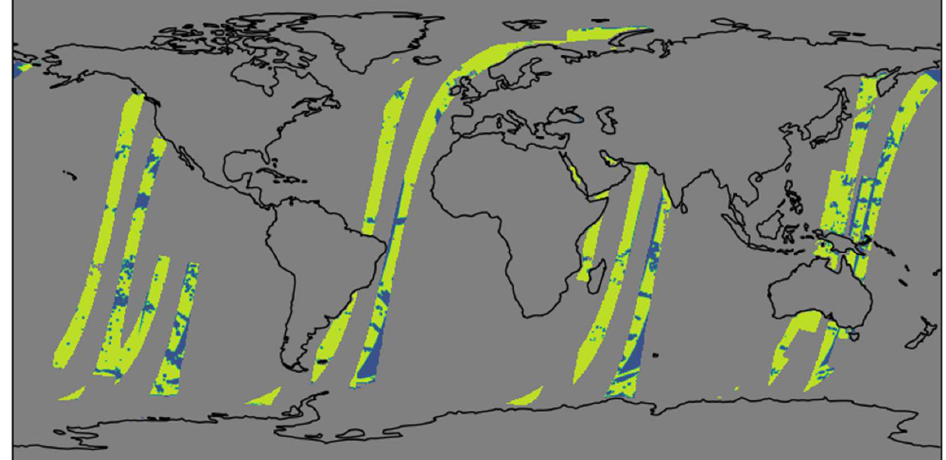
Figure 10. Map of collocations between ASCAT-B and CCMP for an example day (1 January 2018), for the ascending passes of ASCAT-B. Locations where CCMP included a satellite observation from any satellite (SAT) are shown in yellow and locations without a satellite in CCMP (NOSAT) are shown in blue. NOSAT collocations occur for two reasons: (1) Satellite observations were excluded from CCMP because of rain contamination. These are the irregularly shaped regions spread across the map. (2) The existence of gaps between satellite swaths even when all satellites are included. For this day/node, this only occurs in the Southern Ocean and on the extreme left side of a few swaths near the equator. The locations of the satellite gaps vary over time as the swaths for the other satellites drift with respect to ASCAT-B.